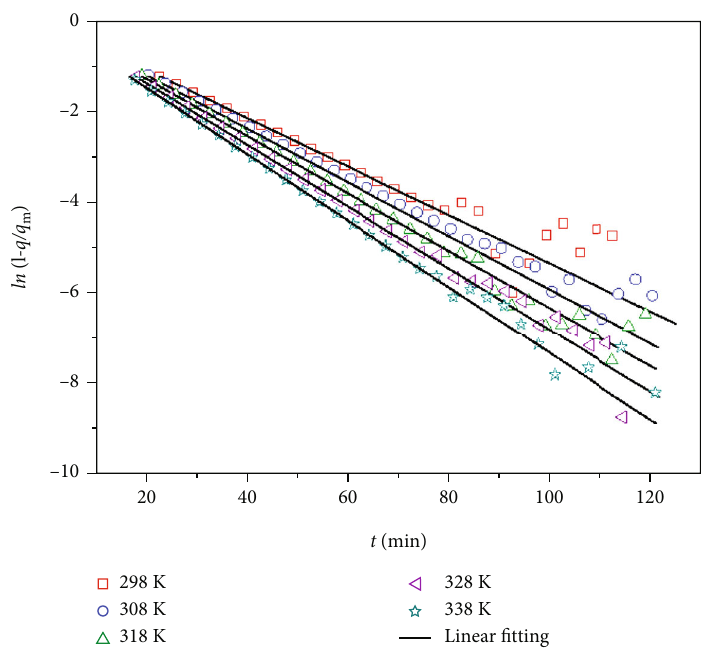
Figure 17: Linear fi tting for experimental data with interparticle di ff usion model. Table 7: The linear fi tting results for interparticle di ff usion